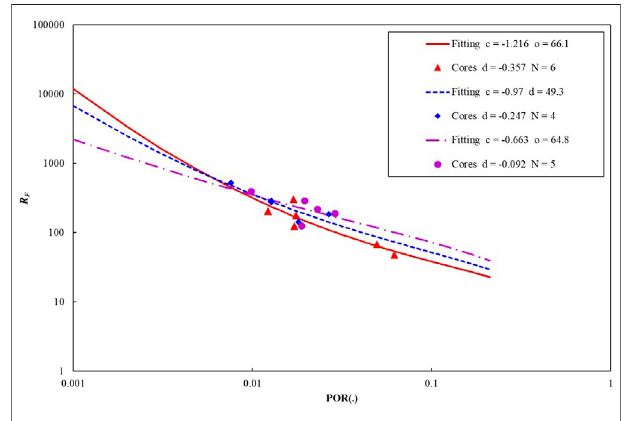
FIGURE 6 | Parameters of c and d for the improved EREM model in group1, group2, and group3.